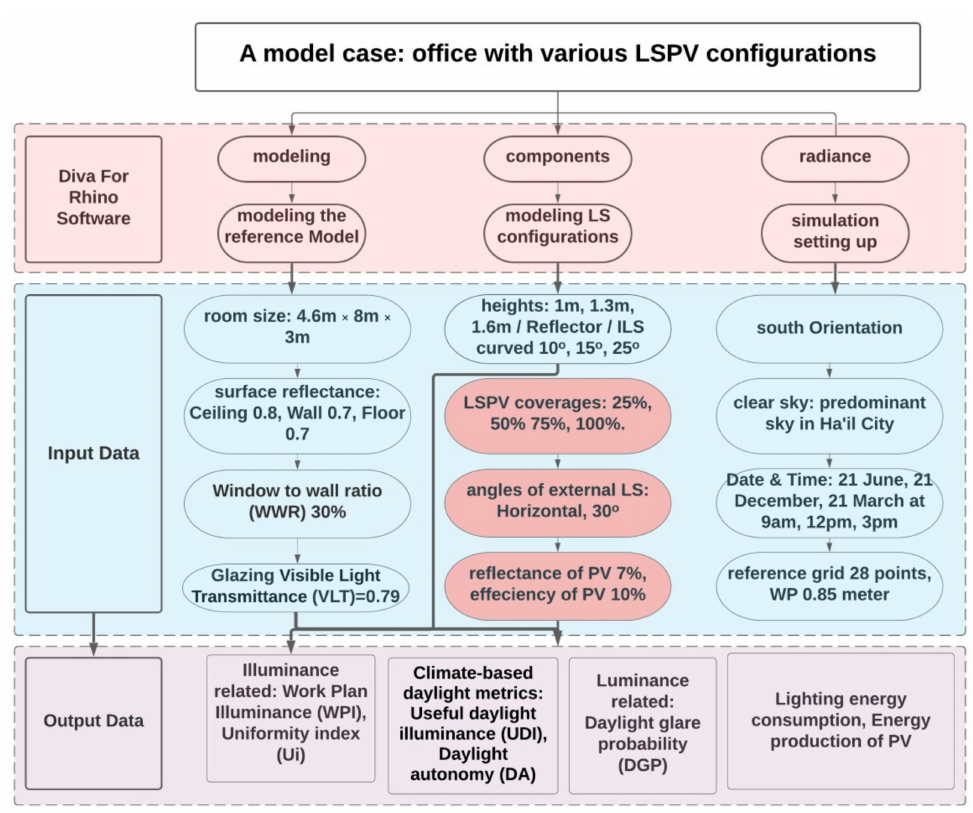
Figure 3. Schematic diagram for the simulation